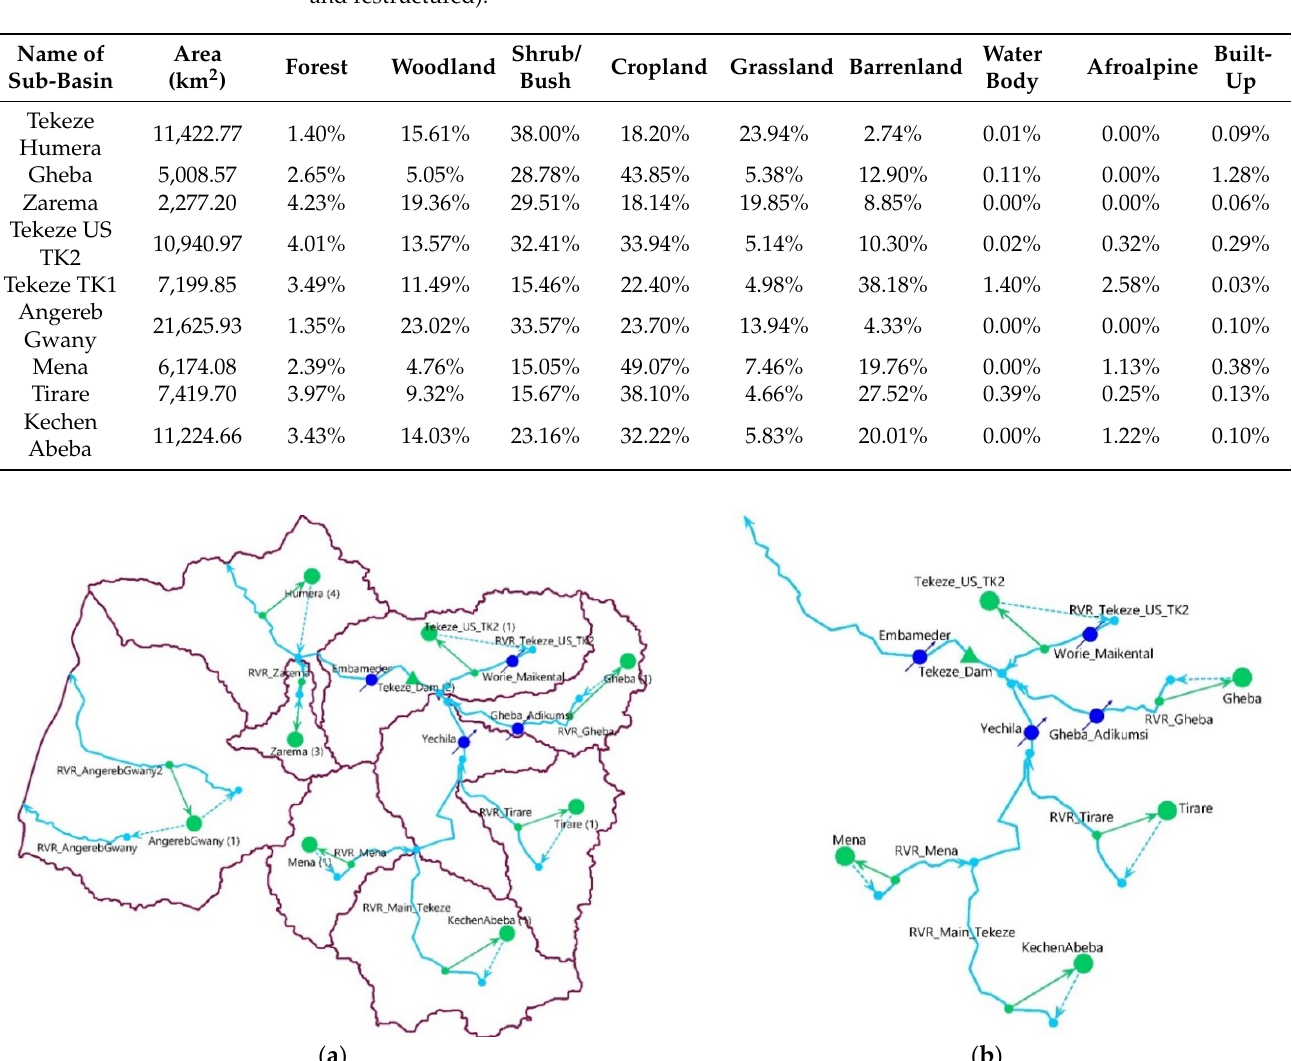
Table 1. Percentage land use–landcover of the catchments in the study area (figure taken from WaPOR portal https://wapor.apps.fao.org/catalog/WAPOR_2/1/L1_LCC_A accessed on 22 March 2021 and restructured).